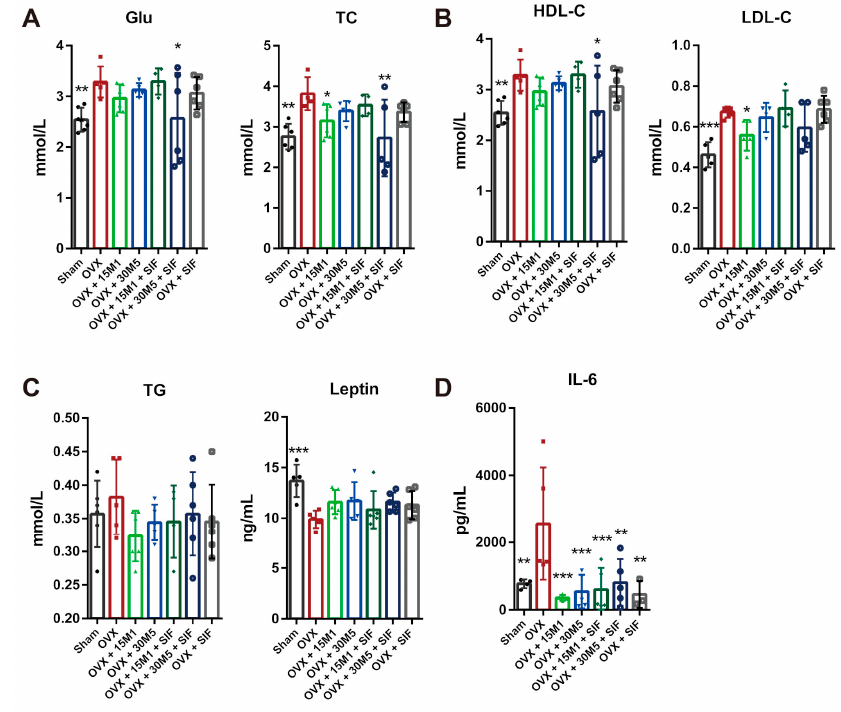
Figure 3. Effect of probiotics and a SIF diet on lipid metabolism and inflammation. ( A ) Glucose (Glu) and Total cholesterol (TC) levels in serum. ( B ) High-density lipoprotein cholesterol (HDL-C) and Low-density lipoprotein cholesterol (LDL-C) levels in serum. ( C ) Triglycerides (TG) and leptin in serum. ( D ) IL-6 level in abdominal fat. * p < 0.05, ** p < 0.01, *** p < 0.001 compared with the OVX group. Data present as the means ± SD. Significant difference between study groups were evaluated using ordinary one-way analysis of variance (ANOVA) and uncorrected Fisher’s LSD multiple comparison test.